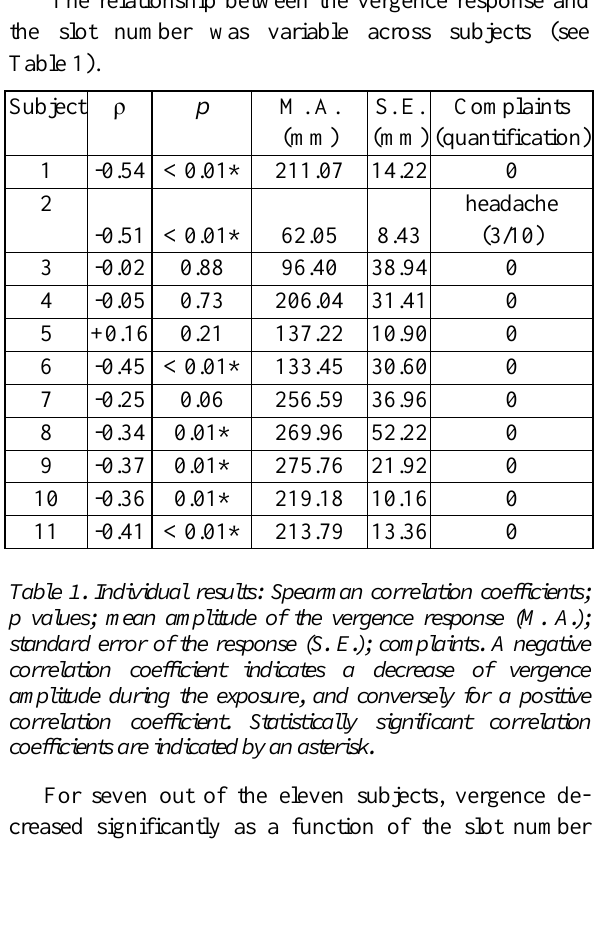
Figure 4. Mean phase lag between the vergence response and the stimulus as a function of the slot number. The error bars around the yellow triangles represent the standard error of the phase lag. Positive phase shifts indicate a delay; whereas negative shifts indicate an anticipation of the vergence response.